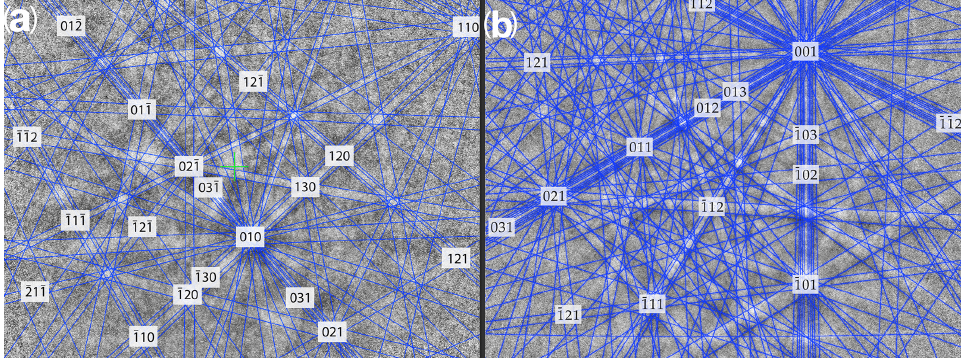
Figure 9. Kikuchi patterns of rhabdophane from a fine-grained aggregate in the fracture of goethite (a) and prismatic crystal from the rims of radial radiant aggregate (b)